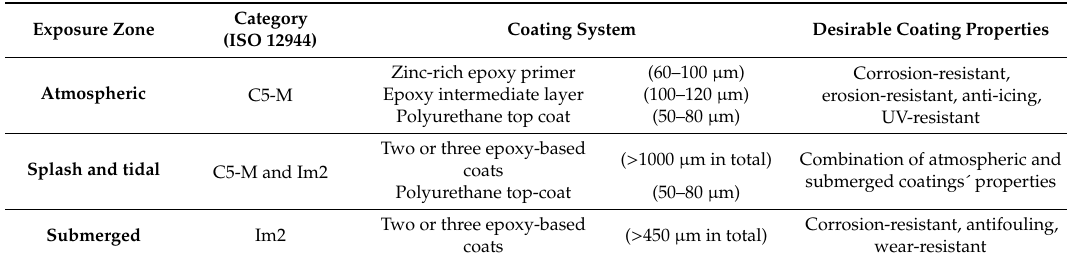
Table 1. Typical coating systems employed in o ff shore applications in the di ff erent exposure zones [19], with the desired properties and corrosivity category required (ISO 12944